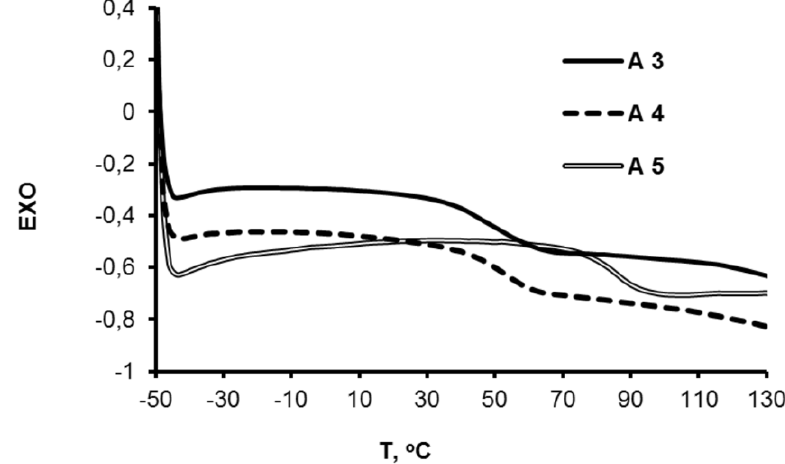
/I ratio as a function of the grafted polysiloxane concentration, corresponding to the samples A1, A3, and 1 3